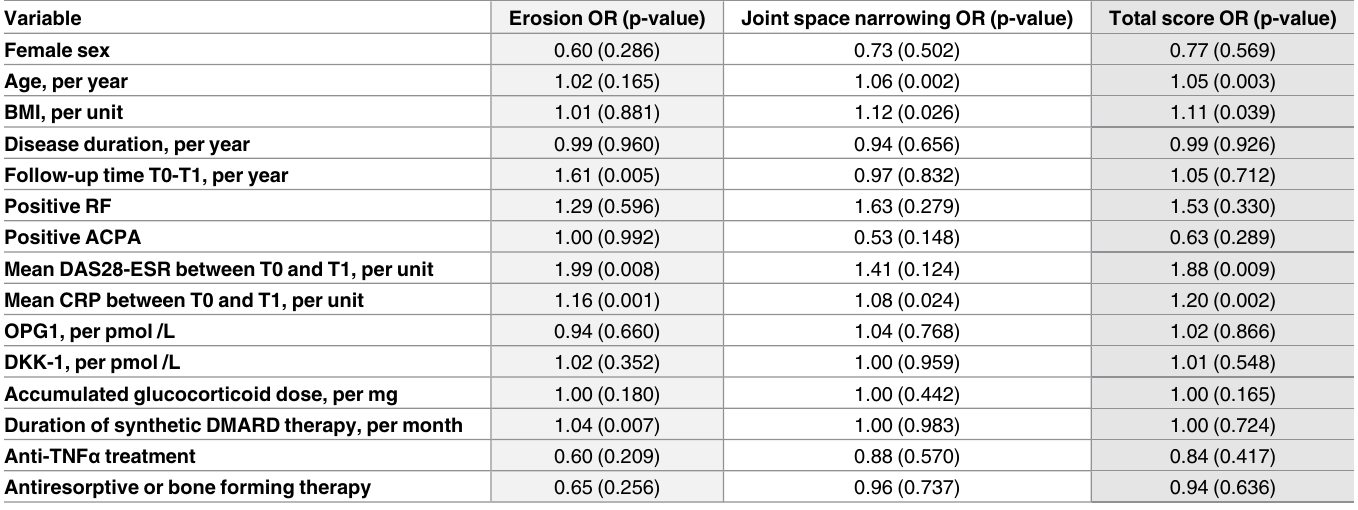
Table 2. Factors associated with radiographic progression by the Sharp-van der Heijde score (total and by subscales): results of the bivariate analysis. Variable